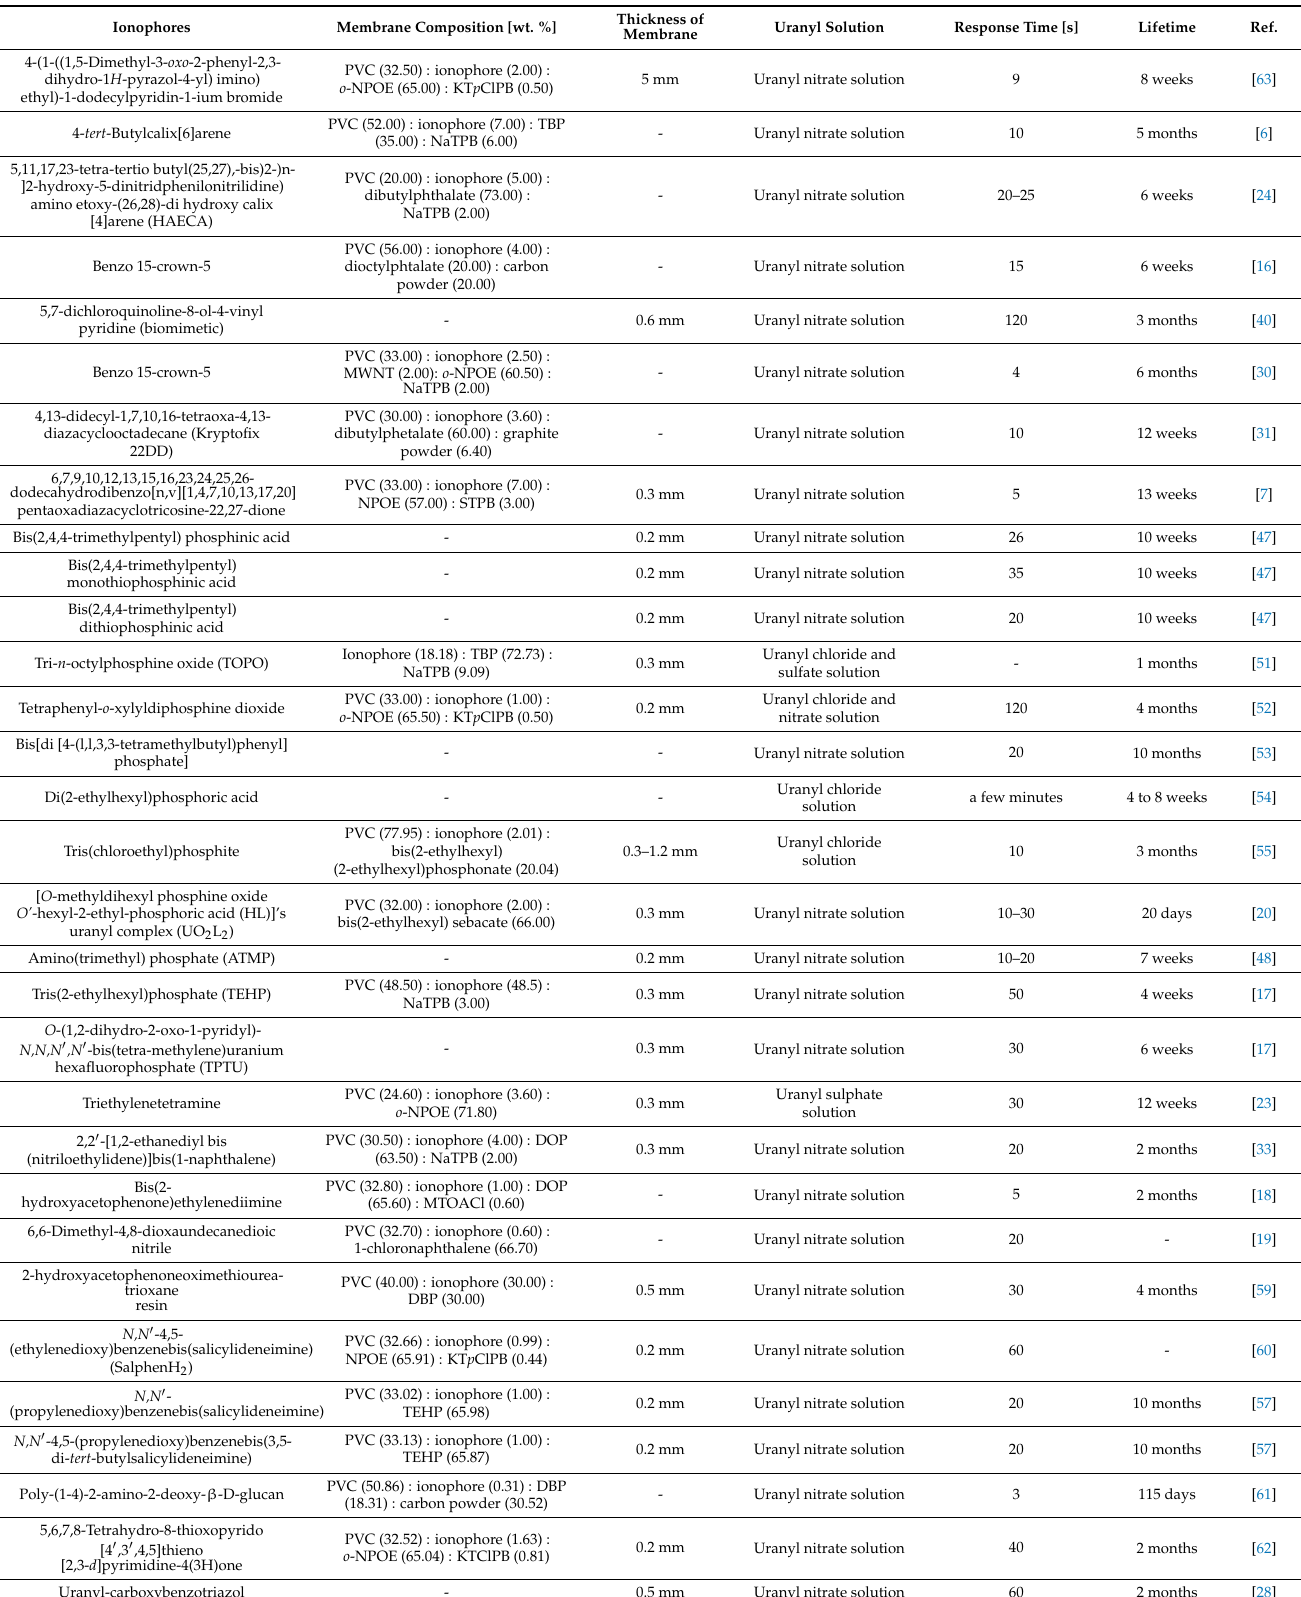
Table 5. An overview of the response time and lifetime of uranium ion-selective membrane electrodes. Ionophores MembraneComposition[wt. %] Thicknessof Membrane UranylSolution ResponseTime[s] Lifetime